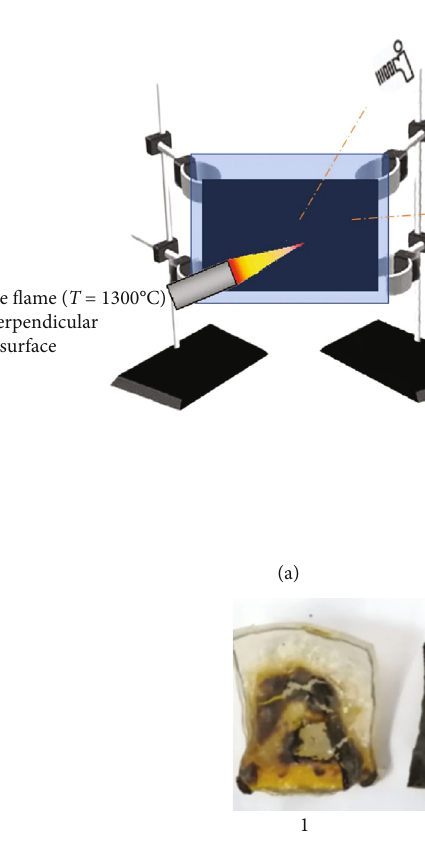
BO , and (d) PVA/15APP-CS/H 3 3